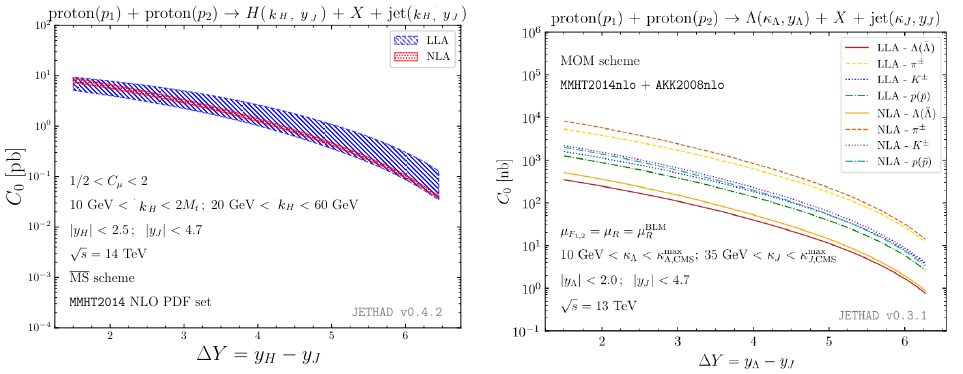
Figure 2: ∆ Y -dependence of the C Higgs-jet (left plot), and Λ -jet process (right plot), with κ max κ max = 60 J , CMS